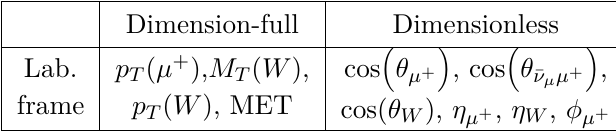
Table 5. Kinematic (dimension-full) and angular (dimensionless) observables selected to study the VLBSM channel. We compute observables in the laboratory frame where θ the respective particles from either the final state or reconstructed objects. Note that ν is the reconstructed missing energy vector, following the discussion in section